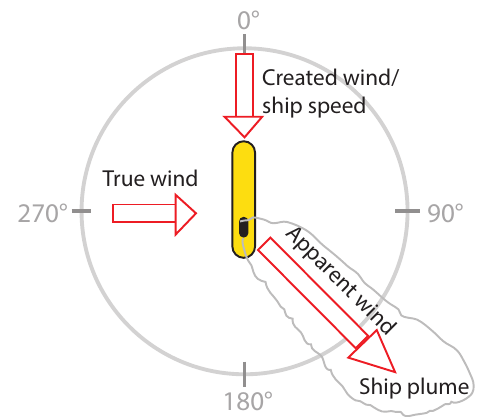
Figure 2. The apparent wind is the resulting wind from the created wind from the speed of the boat and the true wind. The ship exhaust plume follows the apparent wind (figure from Berg et al.,